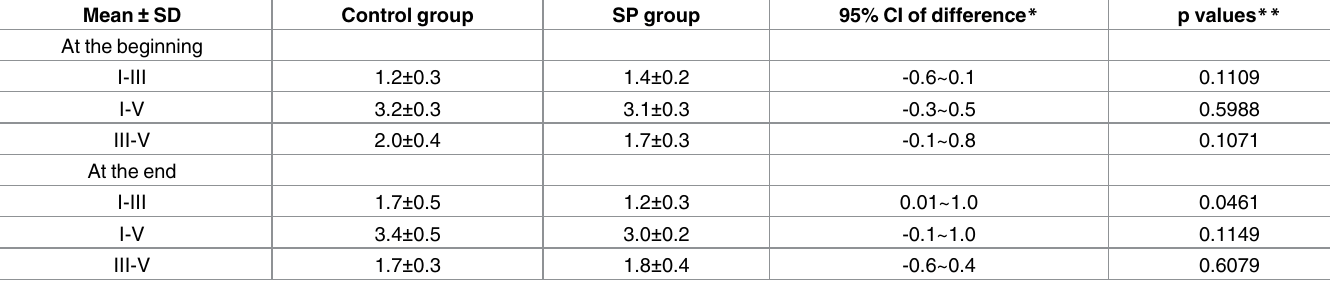
Table 4. ABR intervals by 16k tone burst sound of the both groups at the beginning and the end of this